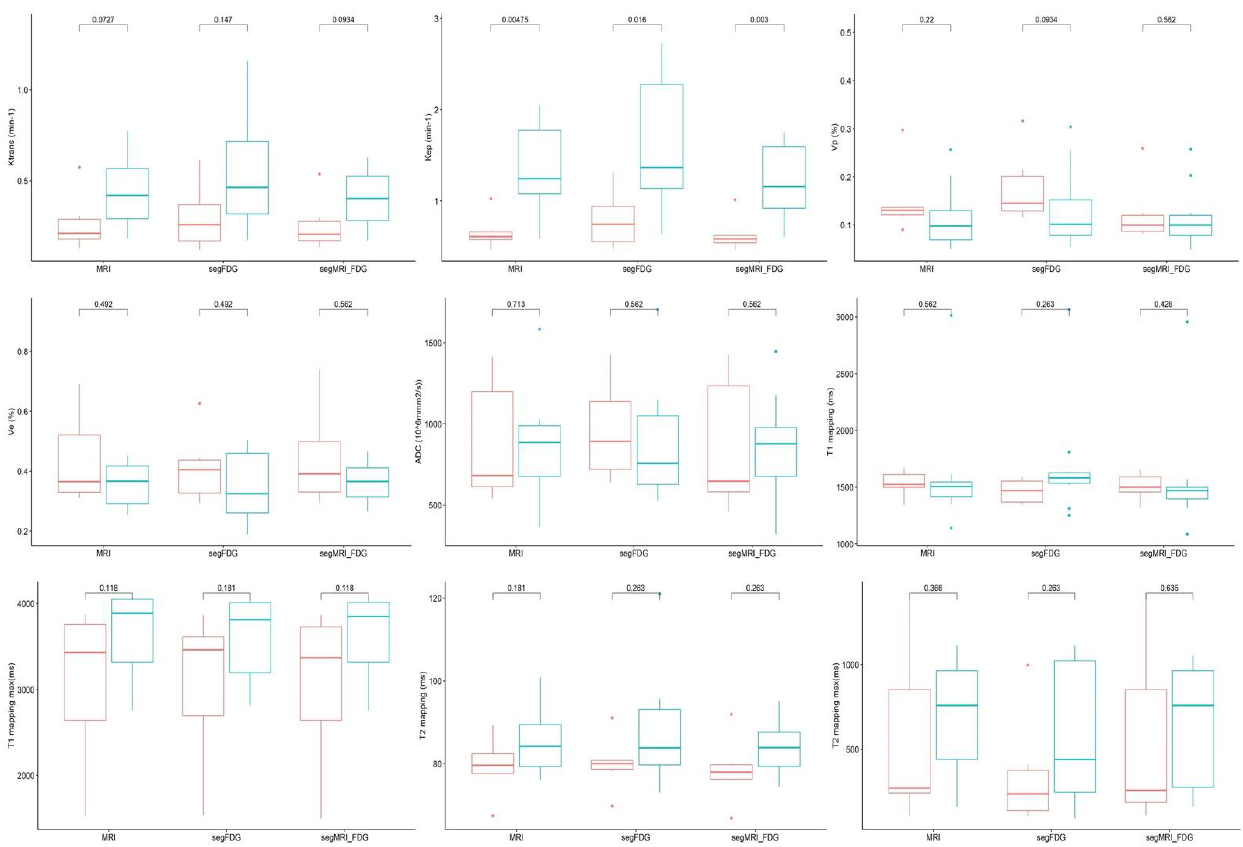
Figure A1. Box plots show evaluation of the difference in each quantitative MRI parameter as a function of tumor volume segmentation method between patients without (red) and with (blue) hypoxic